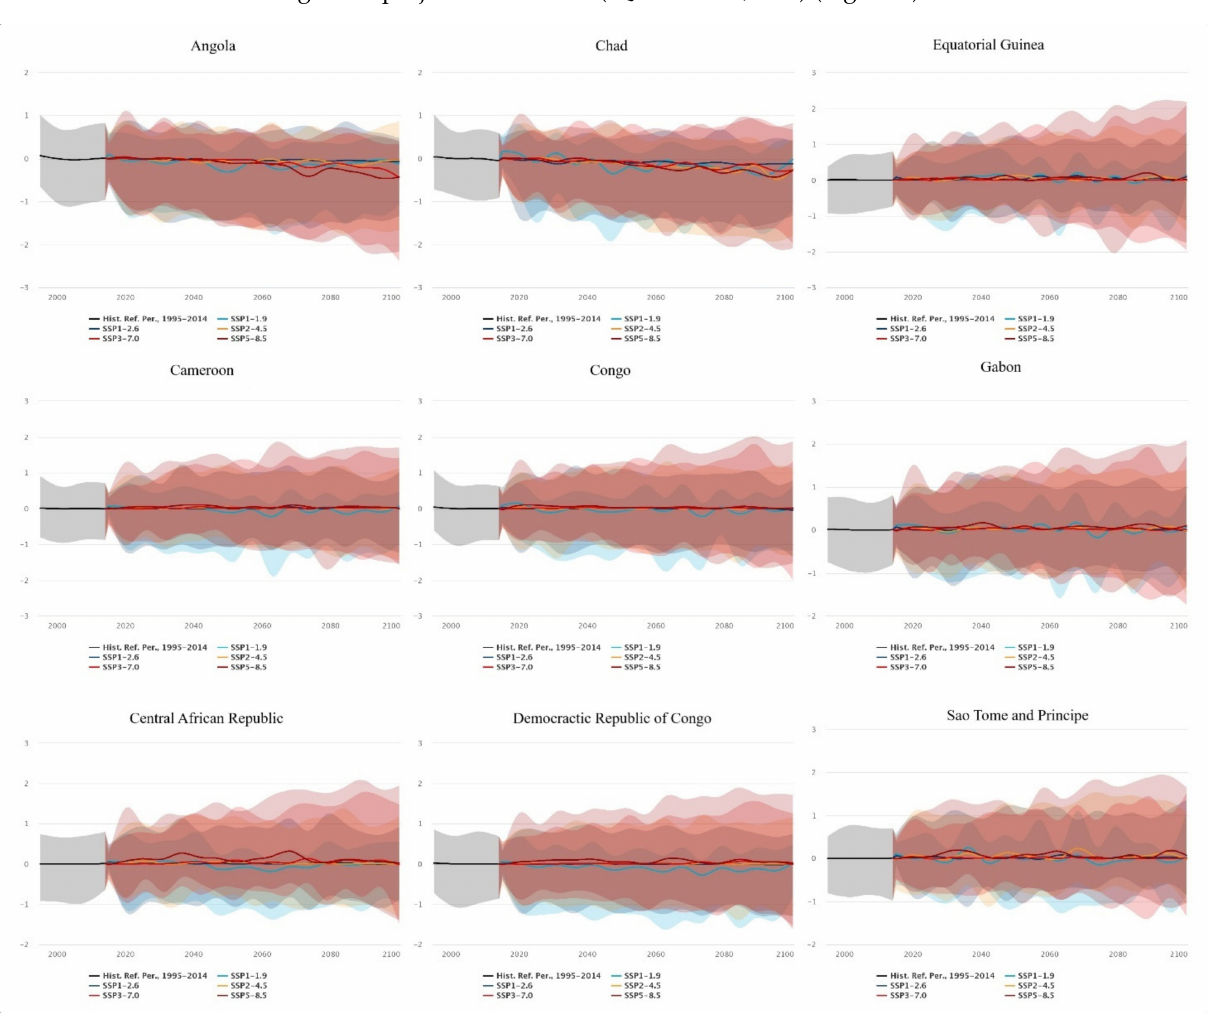
Figure 9. Projected annual SPEI drought index in the Central African Region using a multi-model ensemble with historical reference dated between 1995 and 2014